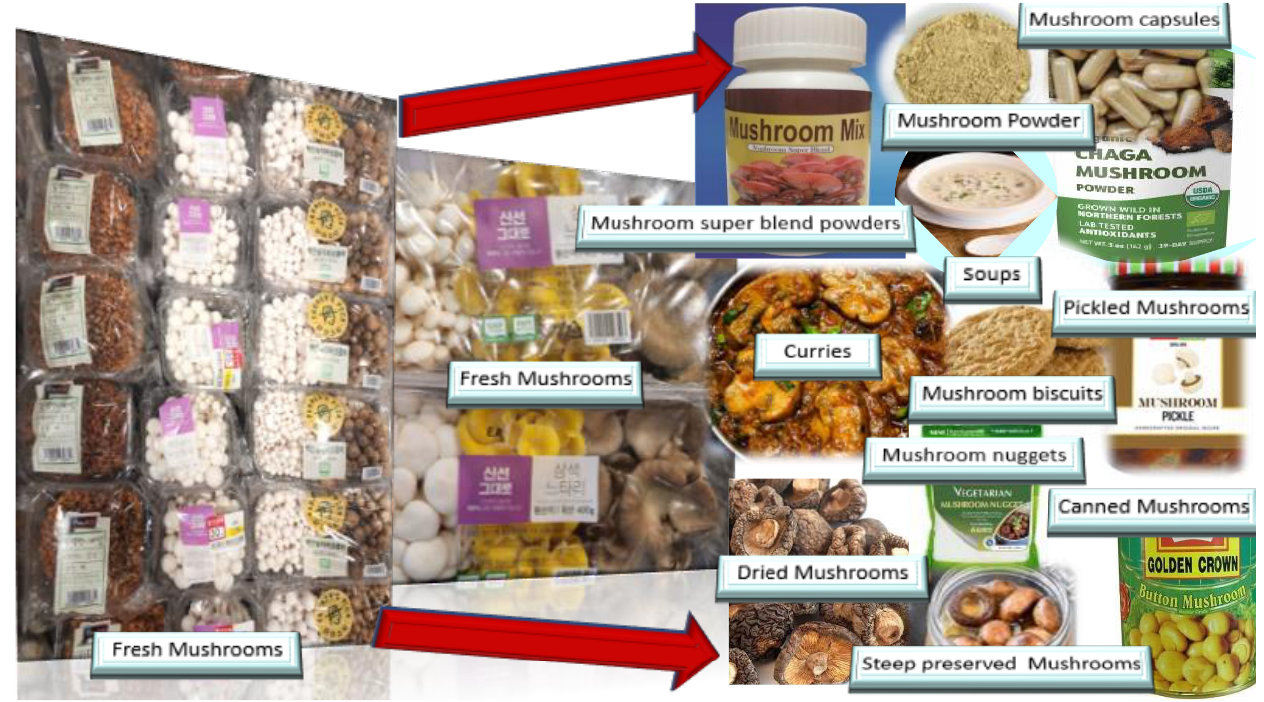
Figure 3. Nutritionally rich mushroom-based foods .